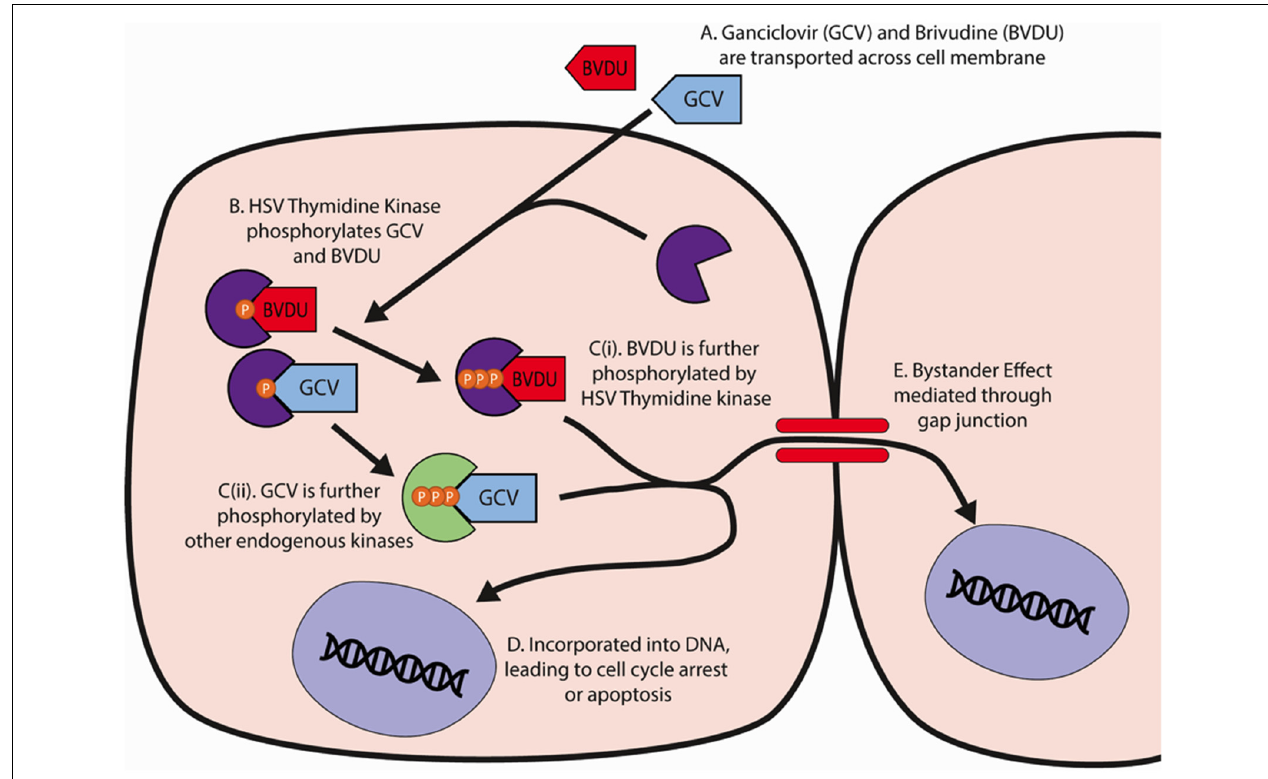
FIGURE 1 | HSV-TK and GCV/BVDU mechanism of action in cell ablation. (A) GCV and BVDU travel through the cell membrane into a cell containing the HSV-Thymidine Kinase. (B) The viral thymidine kinase will catalyze the initial phosphorylation of GCV and BVDU. (C) GCV and BVDU will be further phosphorylated by endogenous kinases and viral kinases respectively, creating nucleoside analogues. (D) The triphosphate forms of GCV and BVDU will be incorporated into DNA, and due to their instability, cause DNA backbone breakages that will lead to cell cycle arrest or apoptosis. (E) GCV and BVDU may be transported through gap junctions, mediating further cell death in neighboring cells. GCV, ganciclovir; BVDU,